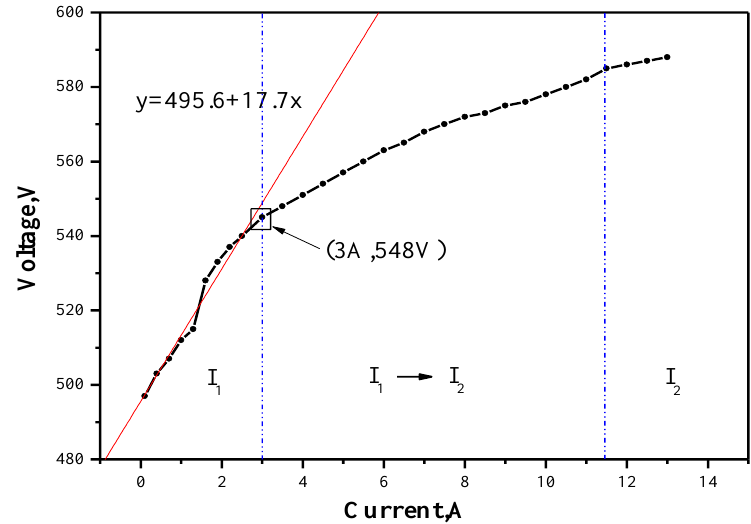
Figure 2. The gas volt – ampere characteristic curve of the copper target.